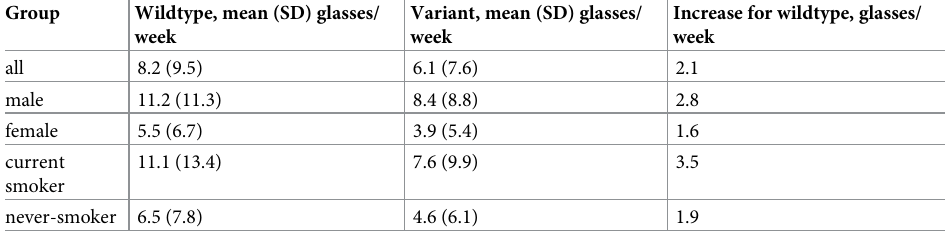
Table 2. Alcohol consumption in equivalent glasses of wine per week by group and ADH1B